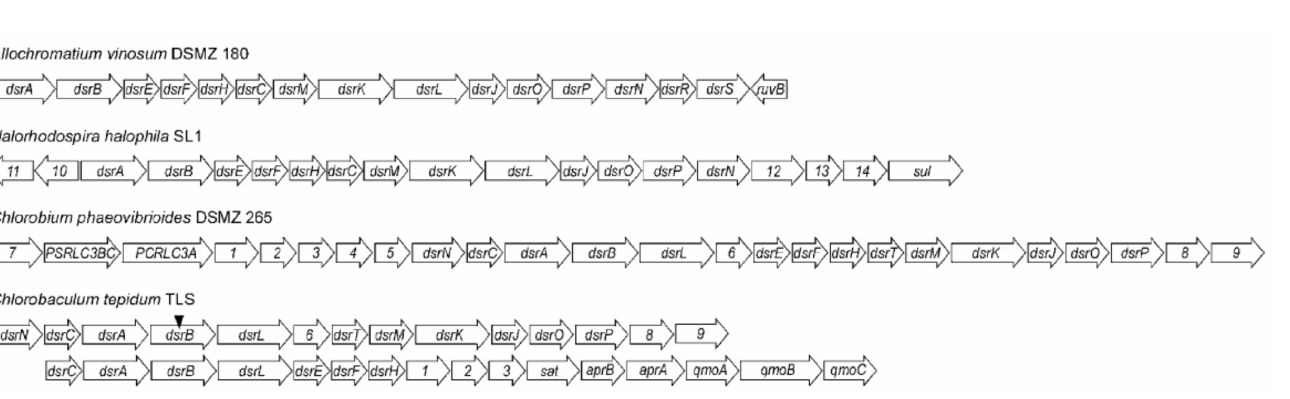
Figure 3. Schematic comparison of the dsr gene region arrangement found in Allochromatium vinosum with another species of phototrophs (data from Frigaard and Dahl, 2009